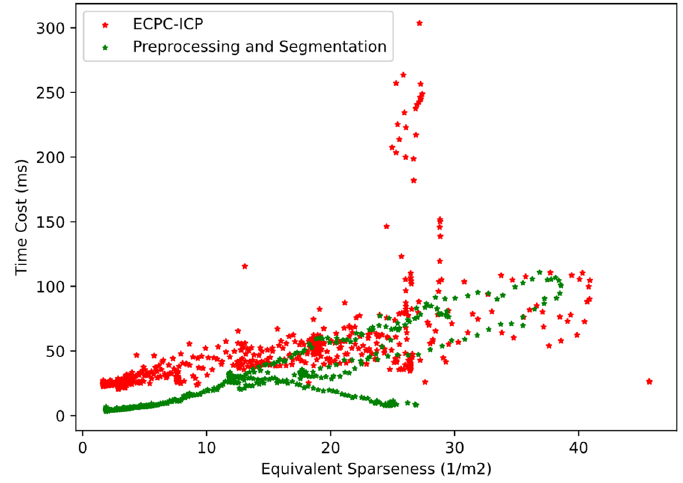
Figure 18. The calculation time cost distribution of ECPC-ICP and the preprocessing and segmentation module in all real environment tests.